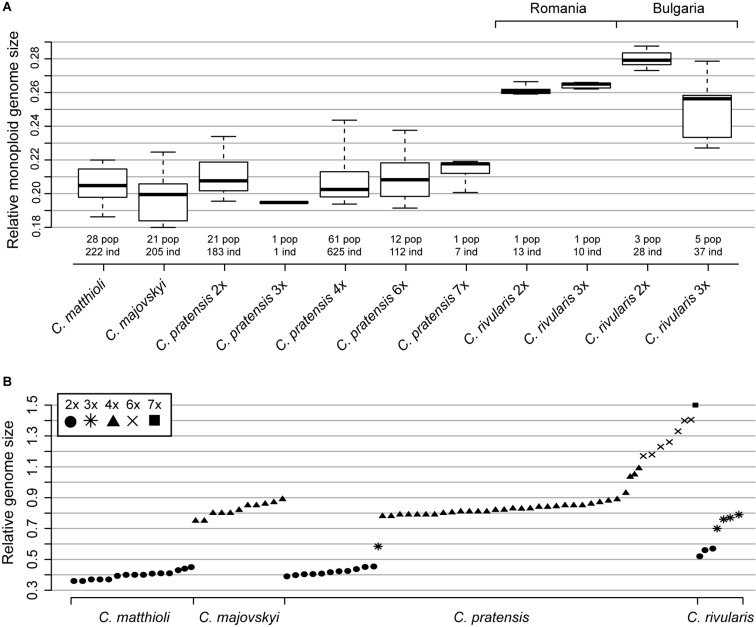
Genome size variation among and within Cardamine matthioli, C. majovskyi, C. pratensis, and C. rivularis.
(A) Relative monoploid genome size (Cx value, following the terminology of Greilhuber et al., 2005) of the species and cytotypes studied. Boxes show interquartile range, and whiskers are extended to the 5th and 95th percentiles. (B) Relative genome size (2C) of the species under study (population mean values). Only representative populations are plotted. The fluorescence intensity of the internal standard Solanum lycopersicum (2C = 1.96 pg) was set to a unit value. Values given under C. rivularis 3x from Bulgaria most likely include both autotriploids of C. rivularis and hybrids between C. rivularis and C. matthioli (see the text for further explanations). Detailed population-, cytotype-, and species-level values are listed in Supplementary Data 1 and Supplementary Table 2.